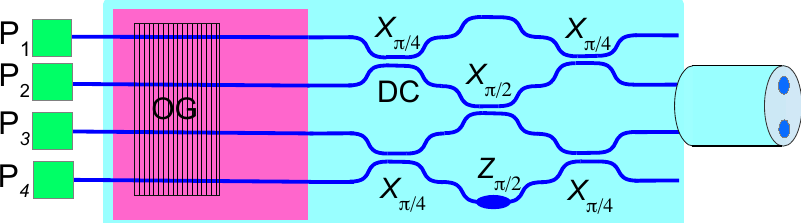
Figure 13. An integrated device with 4 paths (single-mode channel guides) on a hybrid glass substrate is shown. An optical grating (OG) in the active glass section generates four laser weak signals obtained with pumping beams P j , ( j = 1,2,3,4); in the passive glass section, four directional couplers X π /4 and one coupler X π /2 along with a phase shifter Z π /2 generate the four states required for BB84 protocol at the outputs 2 and 3 coupled, for example, to two single-mode cores of a